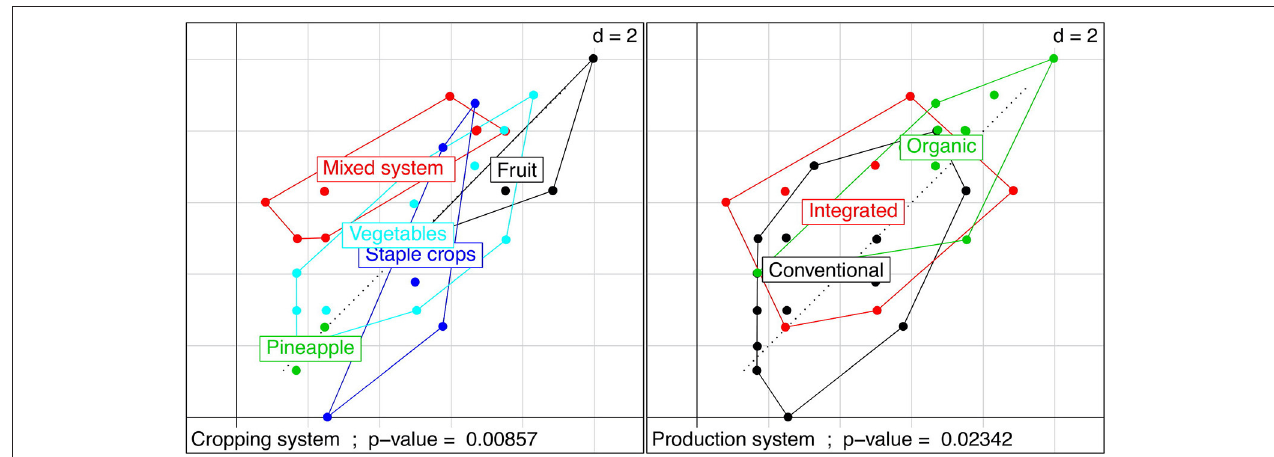
FIGURE 1 | The “cropping system” and “production system” significantly explain the farmers’ ScorePest (y value) and ScoreSoil (x value) situated between 0 and 10 points.